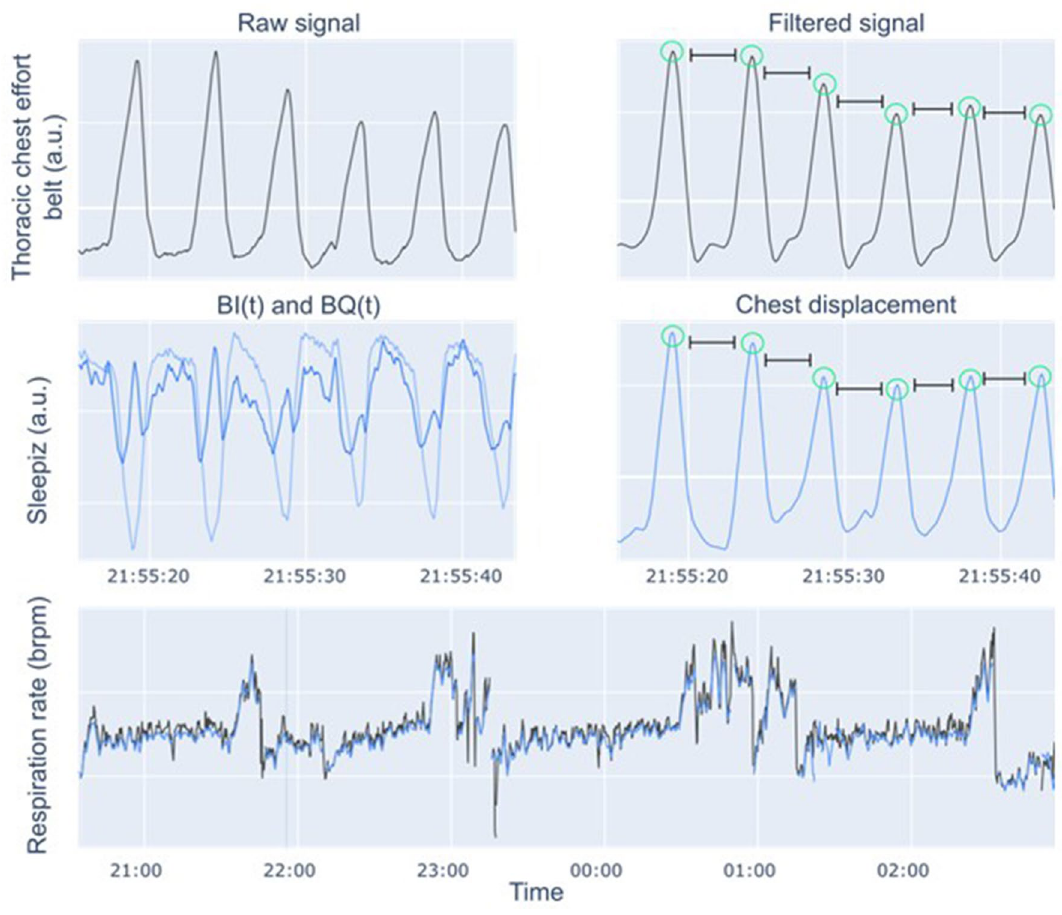
Figure 3. Data processing pipeline. Top row: estimation of instantaneous respiratory rate from thoracic chest effort band (TREB). The raw TREB data, presented in arbitrary units (a.u.) is first smoothed, inhalation times identified, and, from these, instantaneous respiratory rate is computed (see “Computation of instantaneous respiratory rate” for a detailed description). Middle row: estimation of instantaneous respiratory rate from Sleepiz One+ data. The raw signals (BI(t) and BQ(t)), presented in a.u. are used to compute the participant’s chest displacement, from which statistics are extracted and used to compute respiratory rate. Bottom row: the instantaneous respiratory rate for the whole night is used to compute summary statistics, i.e. the 10%, 50%, and 90% percentiles of the respiratory rate